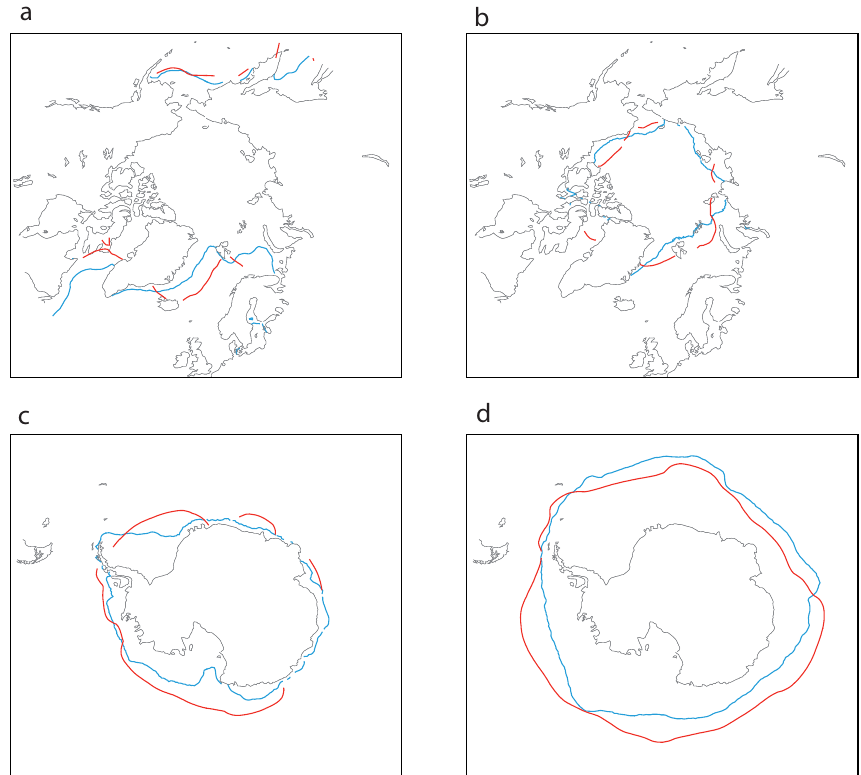
Fig. 12. Location of the sea-ice edge averaged over the period 1980–2000, defined by a monthly ice concentration equal to 15% in (a) March in the Northern Hemisphere, (b) September in the Northern Hemisphere, (c) September in the Southern Hemisphere, (d) March in the Southern Hemisphere. The observations are in blue (Rayner et al., 2003) and LOVECLIM1.2 results are in red.